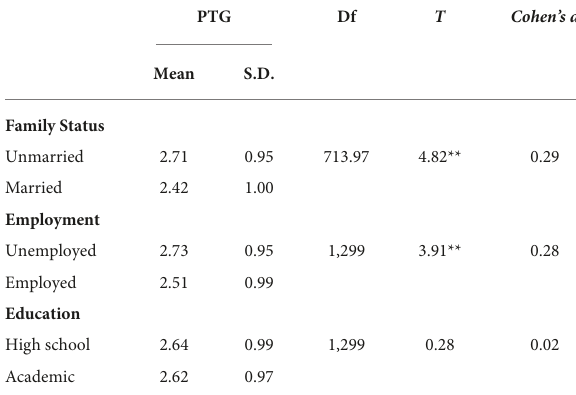
TABLE 2 Differences in PTG by family status, employment and education.